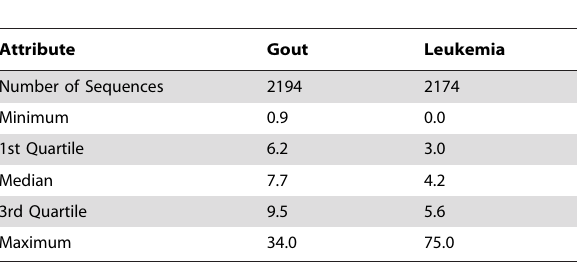
Table 1. Statistical characteristics of uric acid sequences in gout vs.